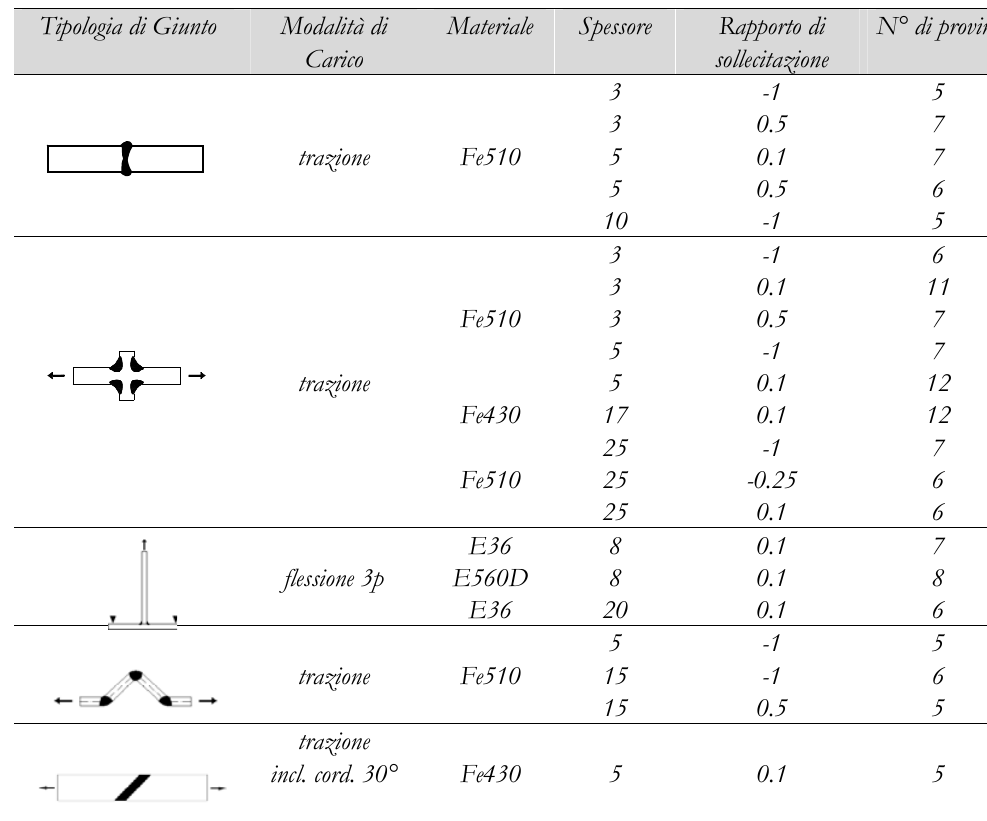
Tabella 1: Riassunto complessivo delle prove di fatica eseguite su giunti in acciaio